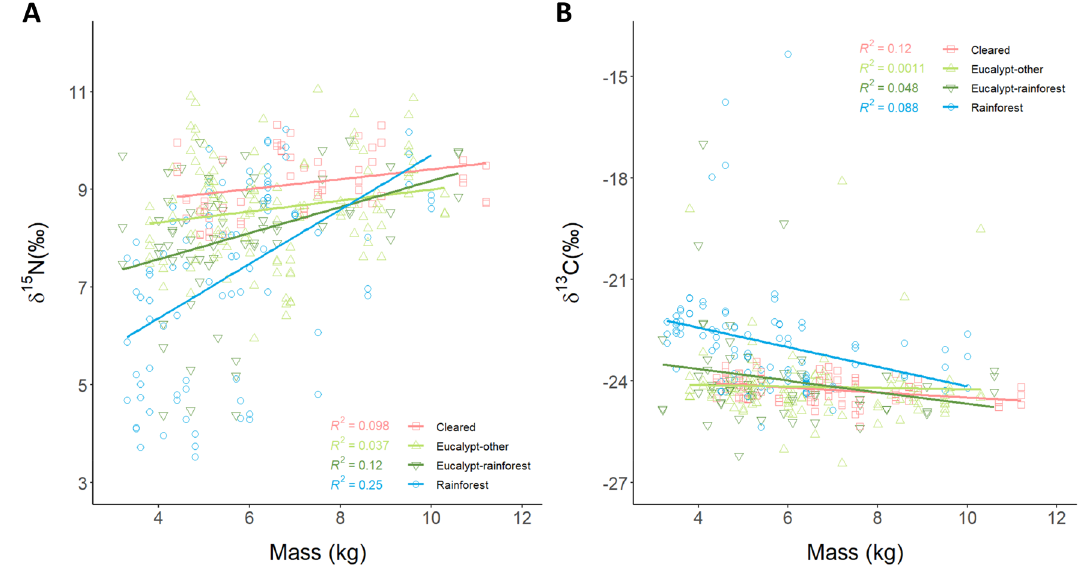
Figure 4. Relationships between ( A ) δ 15 N and ( B ) δ 13 C values (‰) and mass (kg) for Tasmanian devils ( A n = 115; B n = 117). For δ 15 N values there is an interaction of habitat and mass, with only individuals in the rainforest showing a significant positive linear relationship between δ 15 N and mass (R 2 = 0.25). There is a negative relationship between δ 13 C values and mass, with no interaction of habitat.